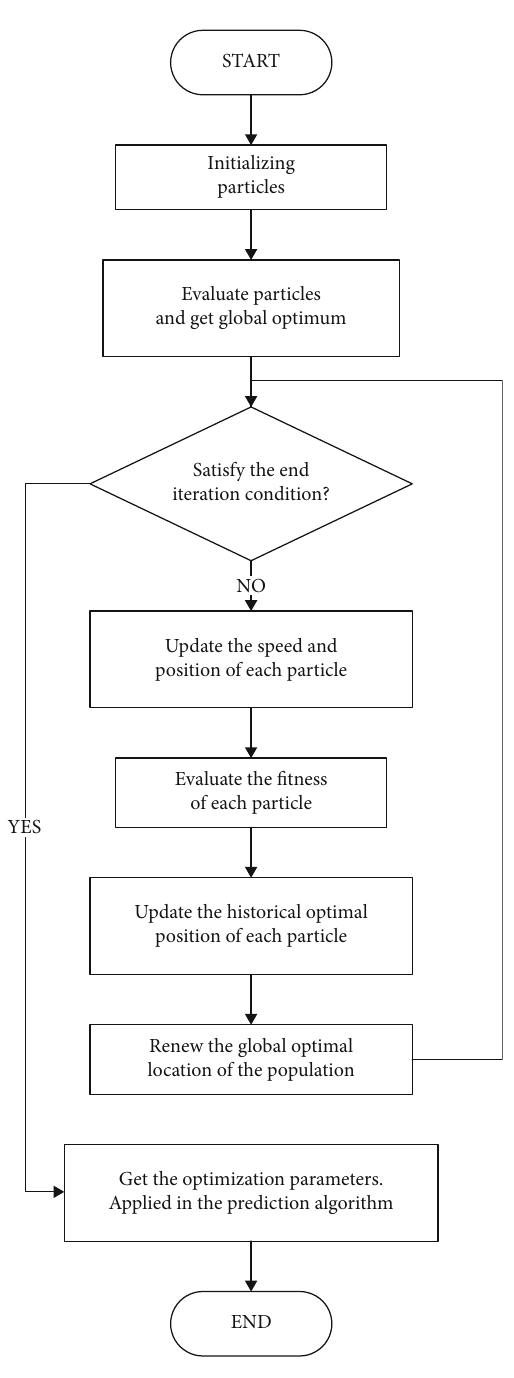
Figure 3: Flow chart of the PSO-Takens algorithm.